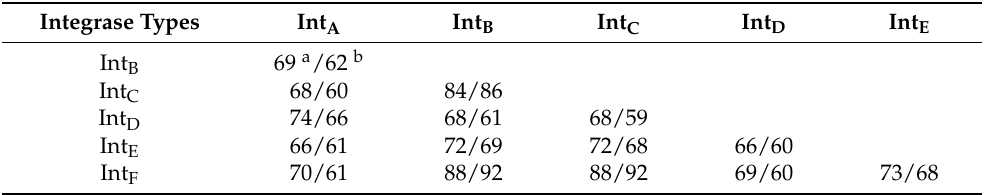
Table 2. Nucleotide and amino acid identities in pairwise comparisons amongst the individual genes of phage integrases in O. oeni